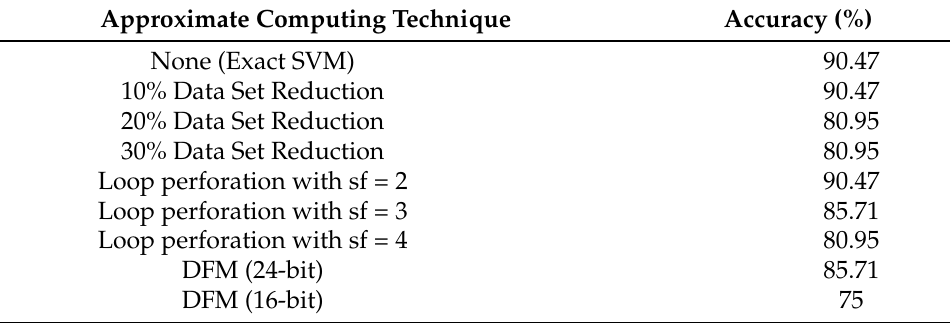
Table 1. Effect of approximate computing techniques on classification